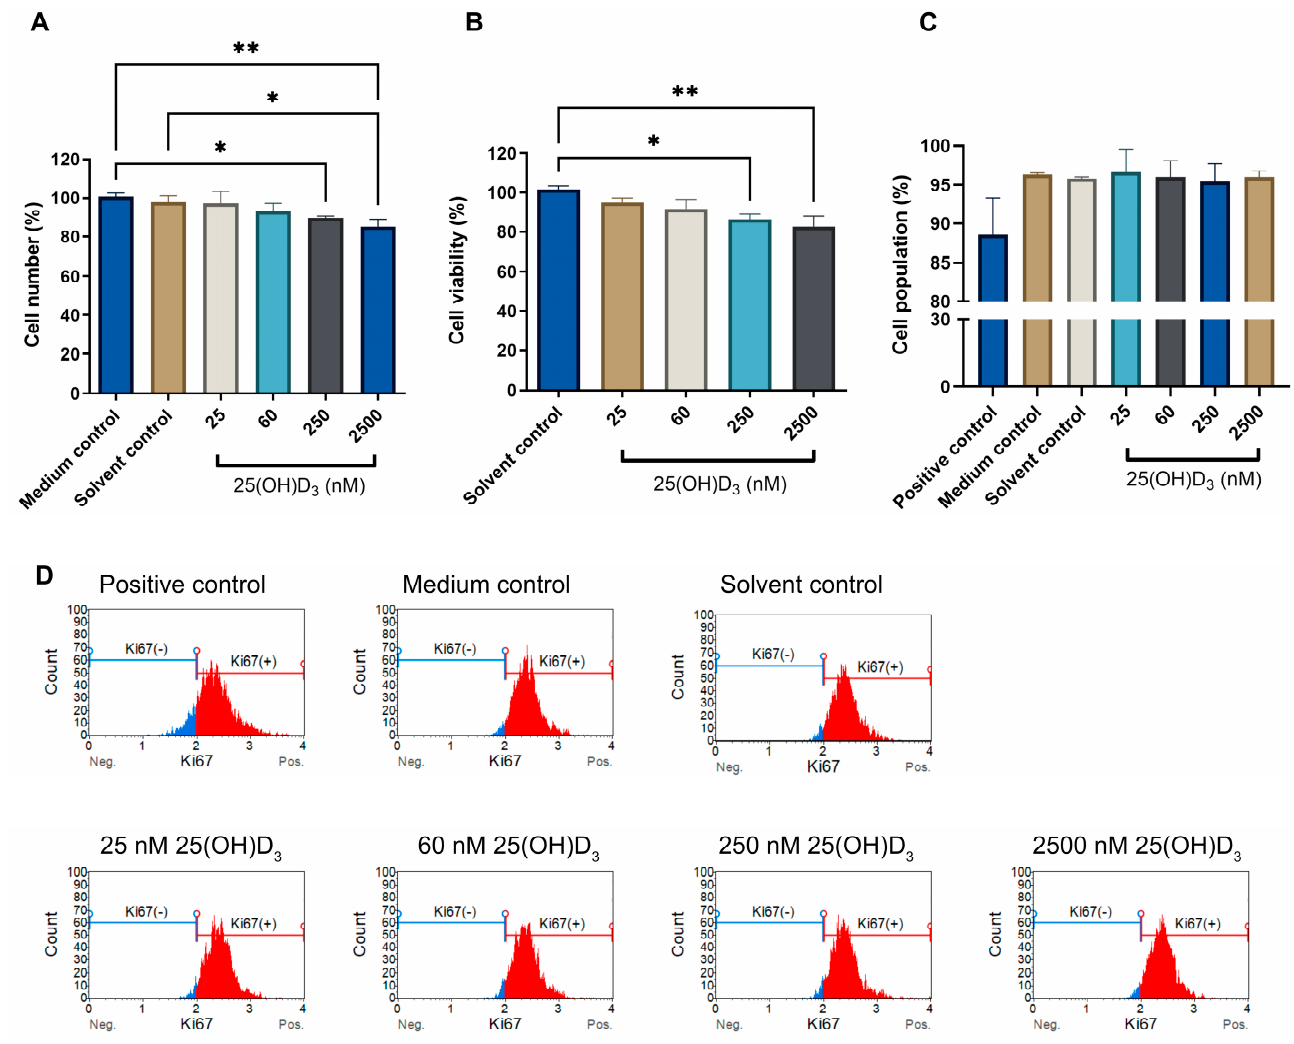
Figure 1. The effect of 25(OH)D3 on cell count ( A ), cell viability ( B ), and cell proliferation ( C ) in SiHa cells. Cell proliferation flow cytometry histograms ( D ) of control and experimental cultures stained for Ki67, show Ki67-positive cell populations (red) and Ki67negative populations (blue). The positive control was treated with actinomycin to a final concentration of 0.1 µ g/mL. Data are expressed as mean ( ± SEM) from three independent experiments, each performed in triplicate (* p ≤ 0.05; ** p ≤ 0.01).